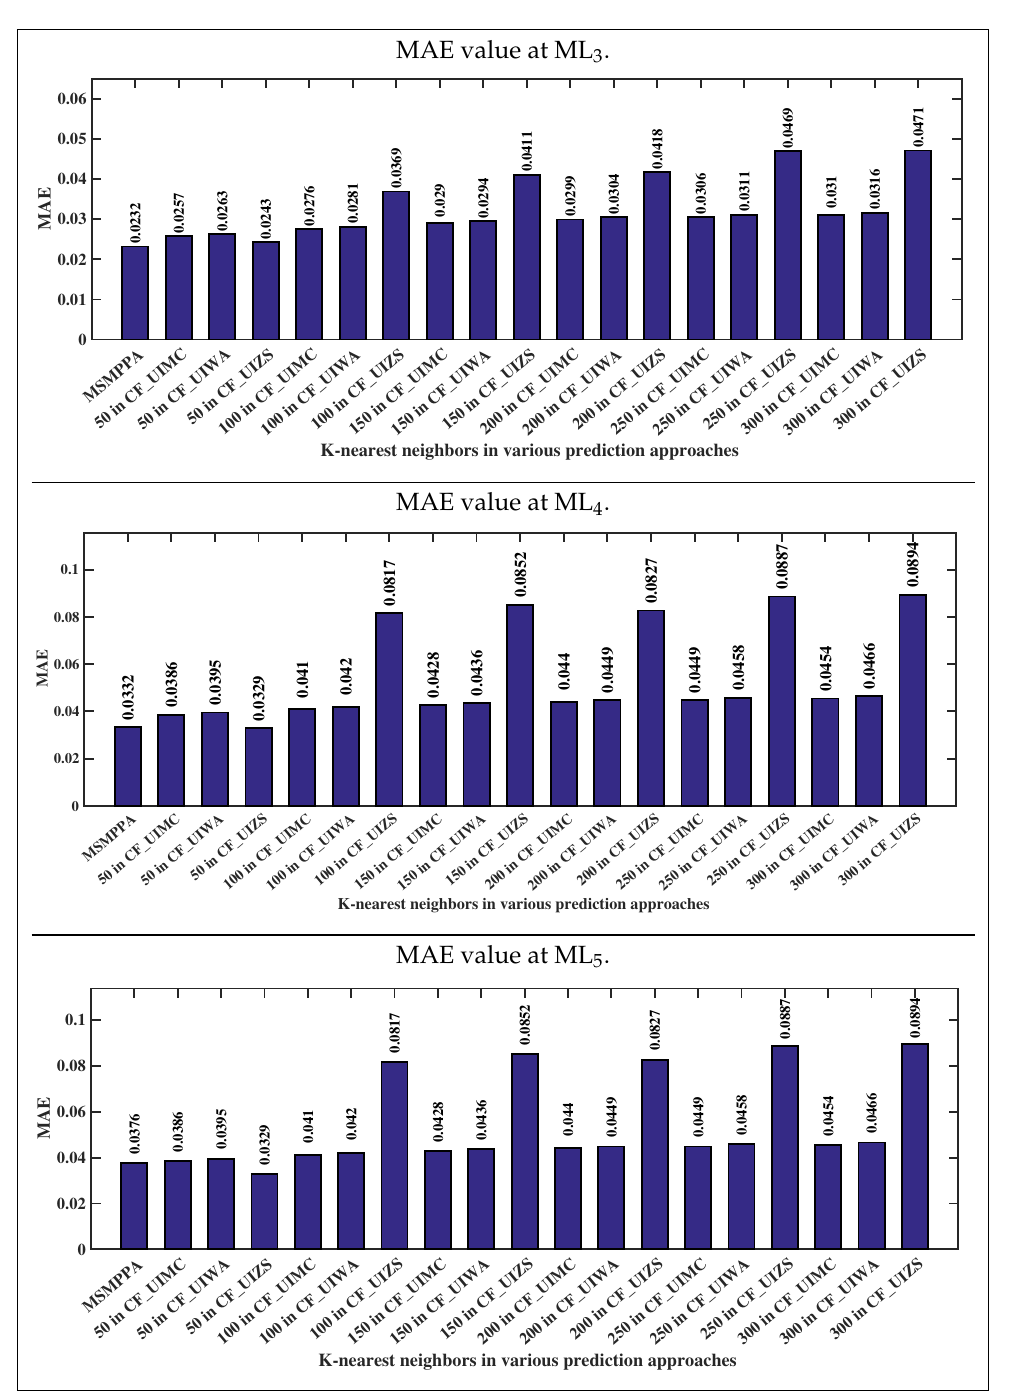
Figure 11. MAE Value at